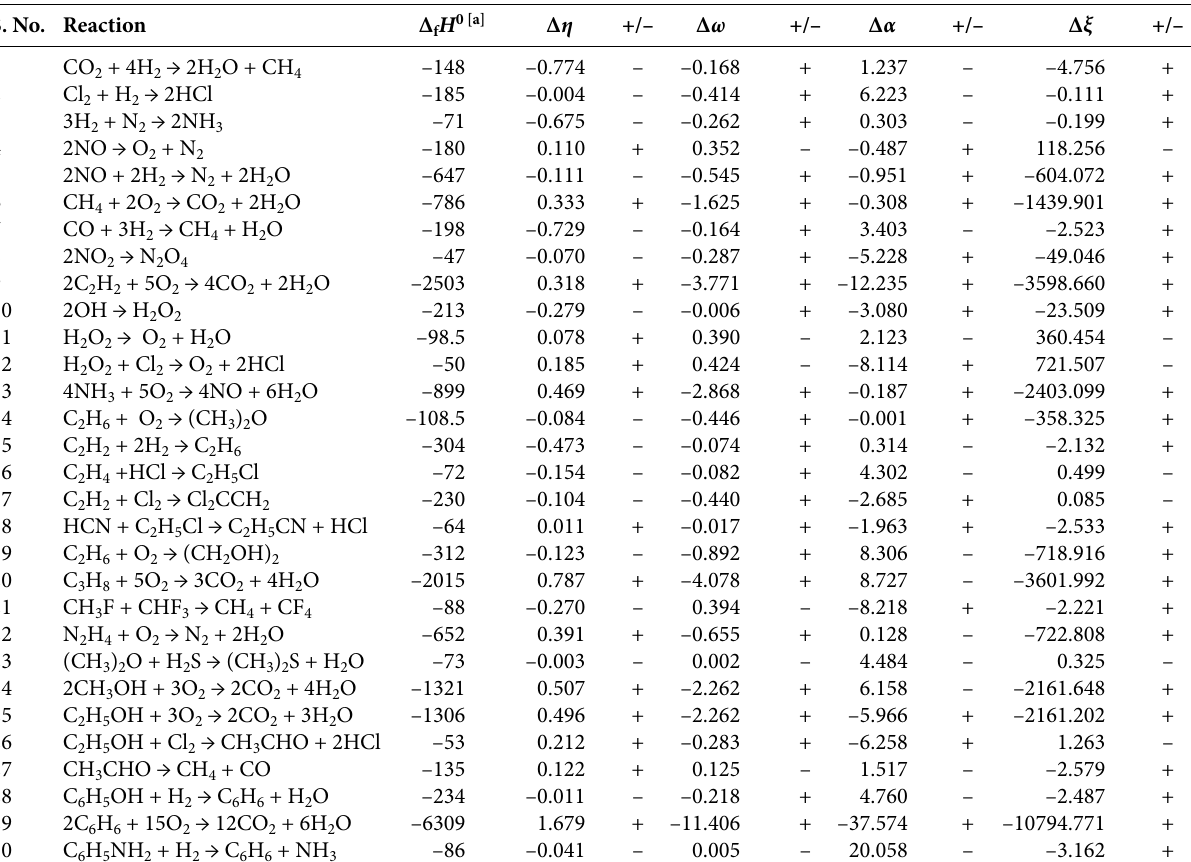
S. No. Reaction Δ f H 0